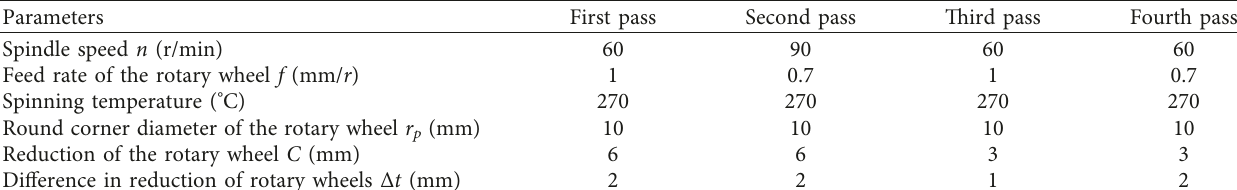
Table 5: Modified process parameters.